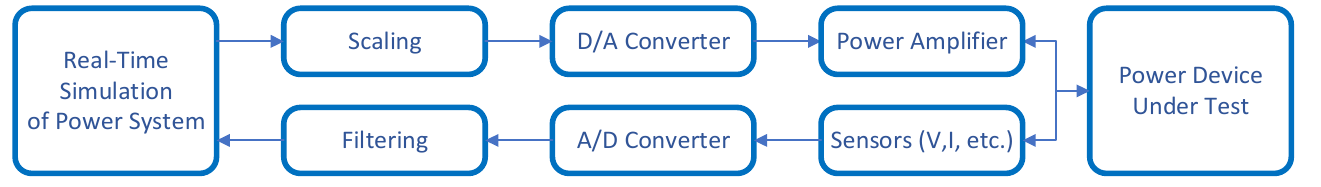
Figure 4. PHIL configuration, adapted from [57].